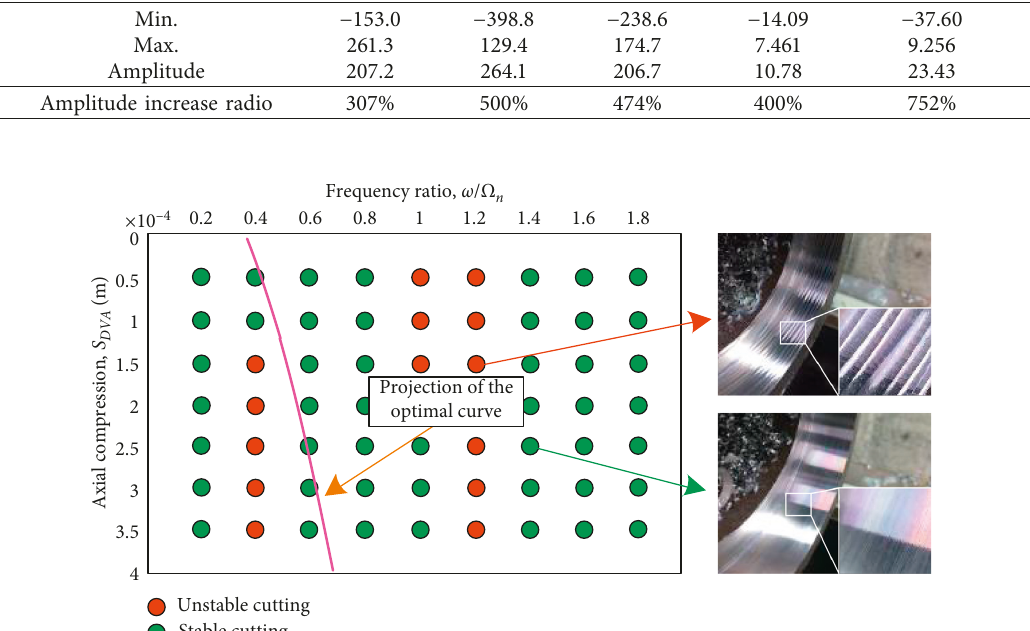
Figure 19: Stable and unstable cutting experiment results.